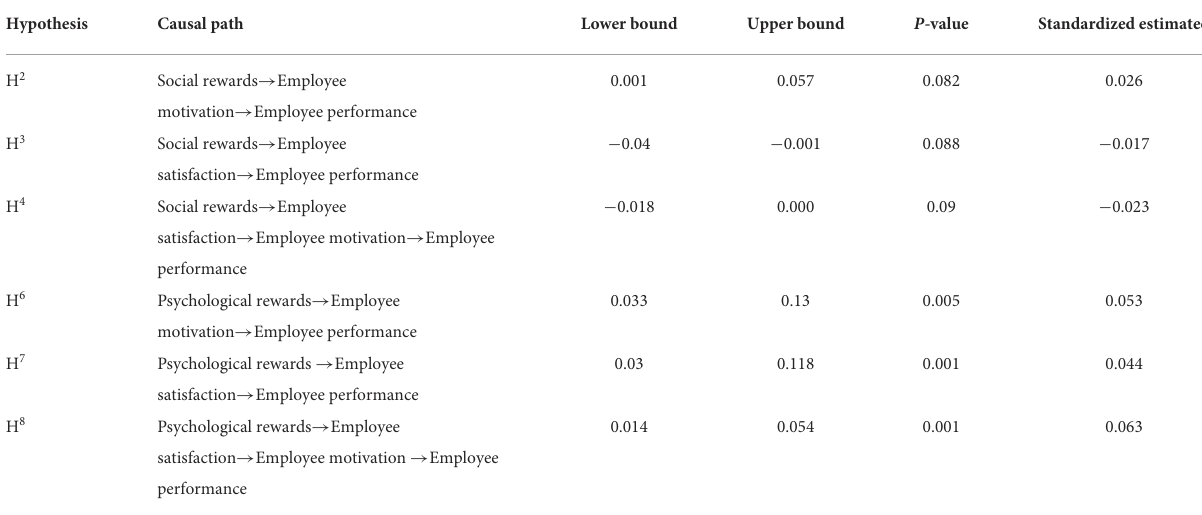
TABLE 7 Results of structural model: indirect effects. Results of structural model: indirect